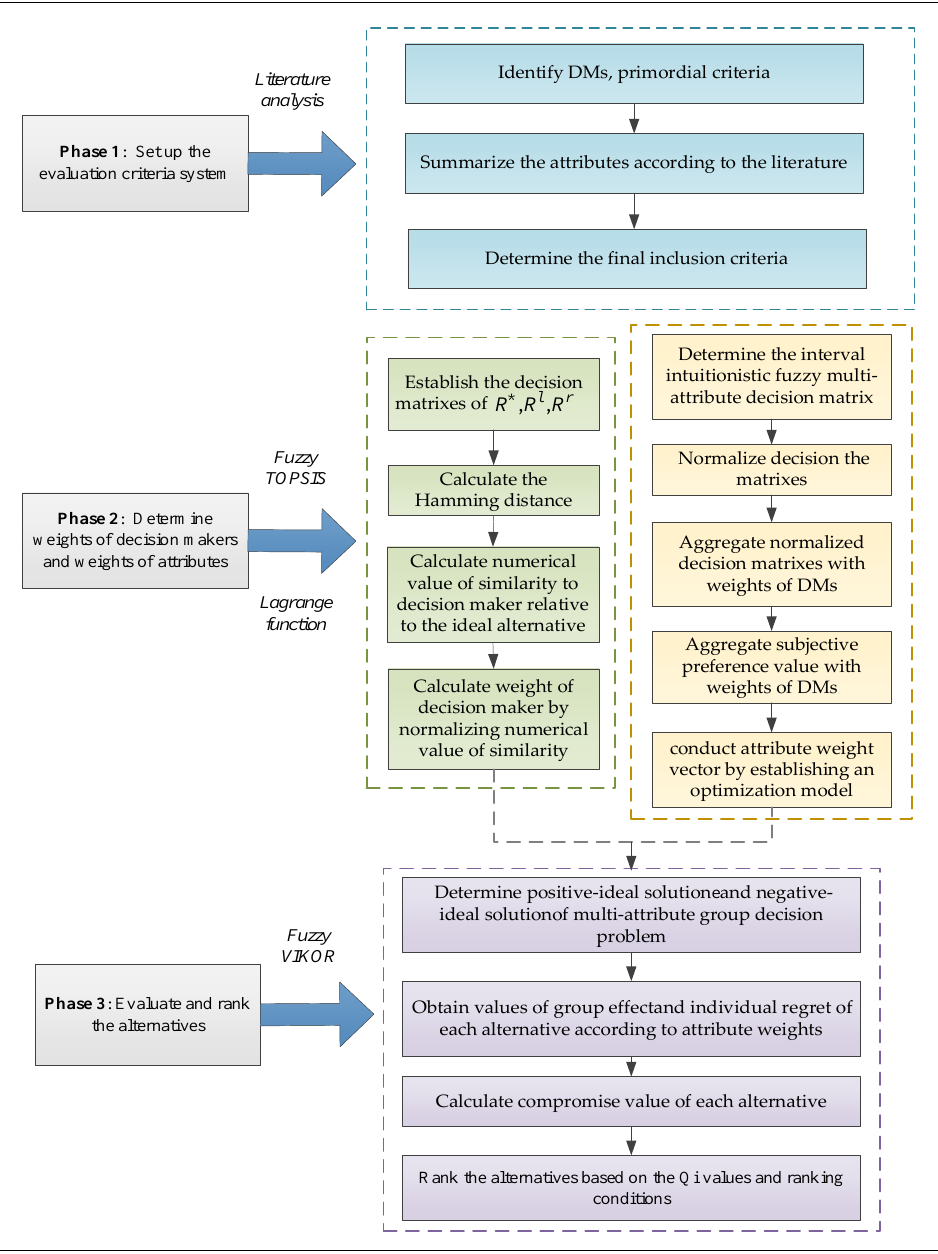
Figure 2. The detailed procedures of the MCDM framework.